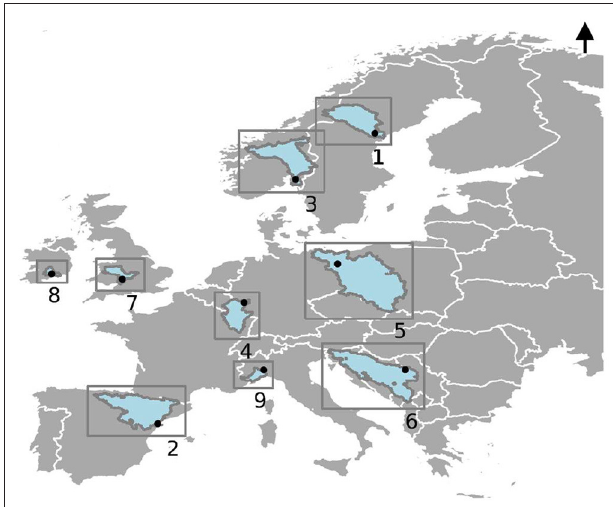
FIGURE 1 | Geographical position of the catchments in Europe. Numbers indicate the river basins; the Ångermanälven (1), Ebro (2), Glomma (3), Moselle (4), Oder (5), Sava (6), Severn (7), Suir (8), and Tanaro (9). Dots indicate the gauge locations used in this study.